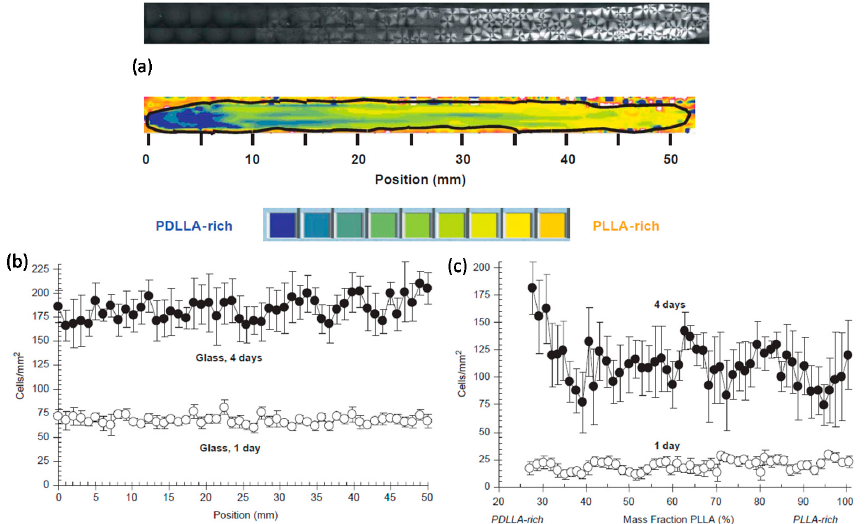
Figure 6. ( a ) Top: An image of the birefringence from a PLLA-PDLLA gradient is shown. The higher crystallinity of the PLLA-rich end of the gradient causes it to be more birefringent than the PDLLA-rich end. The gradient shown is 52 mm long. Bottom: FTIR-reflectance-transmission microspectroscopy (RTM) map of a PLLA-PDLLA composition gradient. The strip film has been outlined with a black line. Blue corresponds to PDLLA rich regions and orange to PLLA-rich regions (see color bar below map); ( b ) Cell adhesion and proliferation on the PLLA-PDLLA gradients and on control glass slides. Adhesion data for 1 day and for proliferation data for 4 days are plotted; ( c ) Same data as b on the PLLA-PDLLA gradient substrate [58].